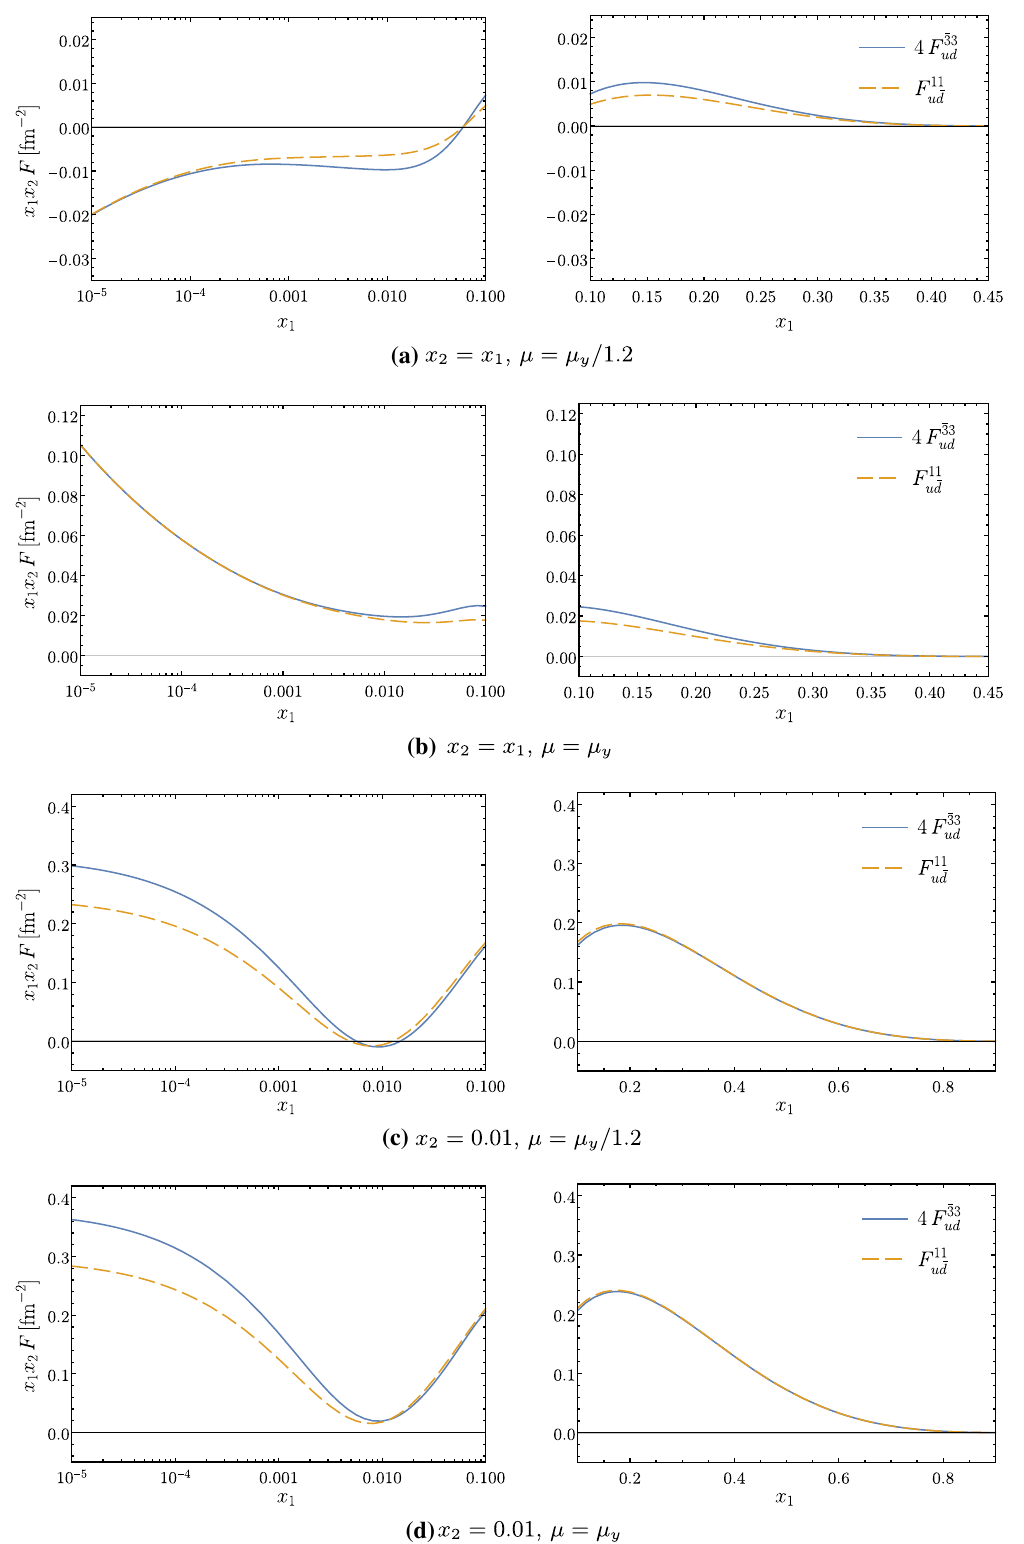
Fig. 8 The distributions F 33 and F 11 computed with the two-loop splitting formula for μ y = 10GeV and two choices of μ . The other two colour ud u ¯ d channels are given in